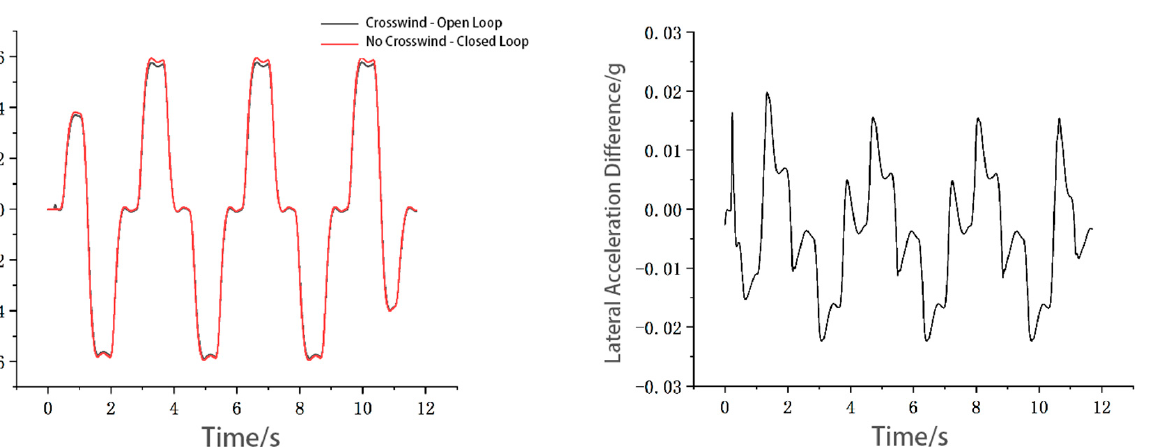
Figure 17. Comparison curves and difference curves of roll angle velocity with and without cross- wind effect.